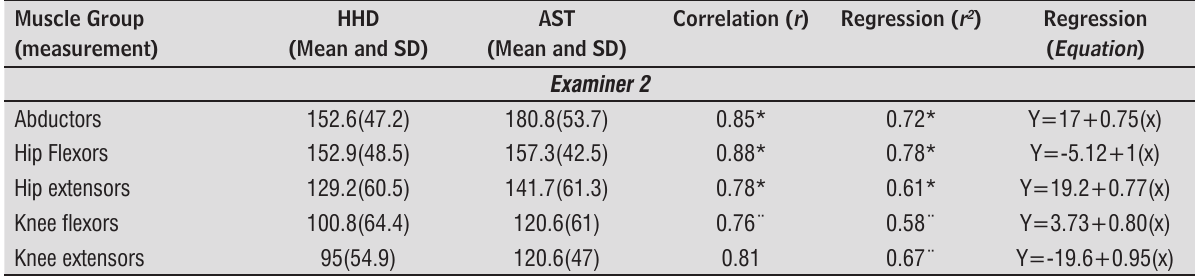
Table 3 - Descriptive statistics (mean ± SD), Pearson’s correlation coefficient and regression analysis (r 2 ) of the first force repetition, presenting data from examiners 1 and 2, on the first day of evaluation, n =